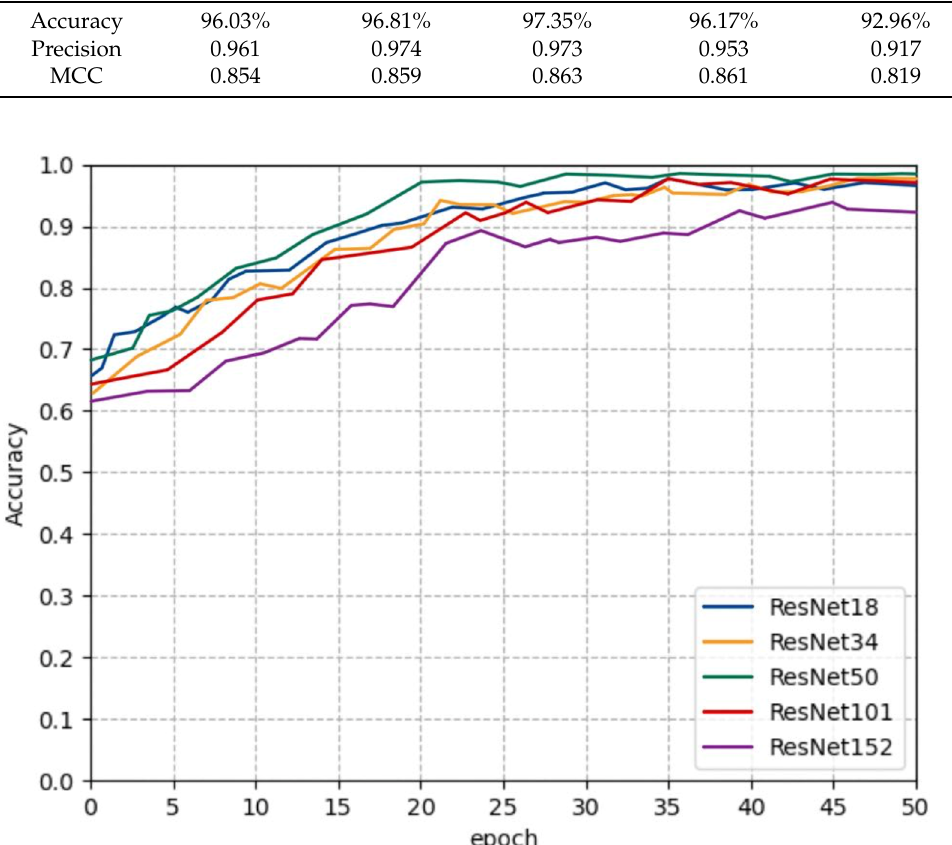
Figure 10. Training process of ResNet